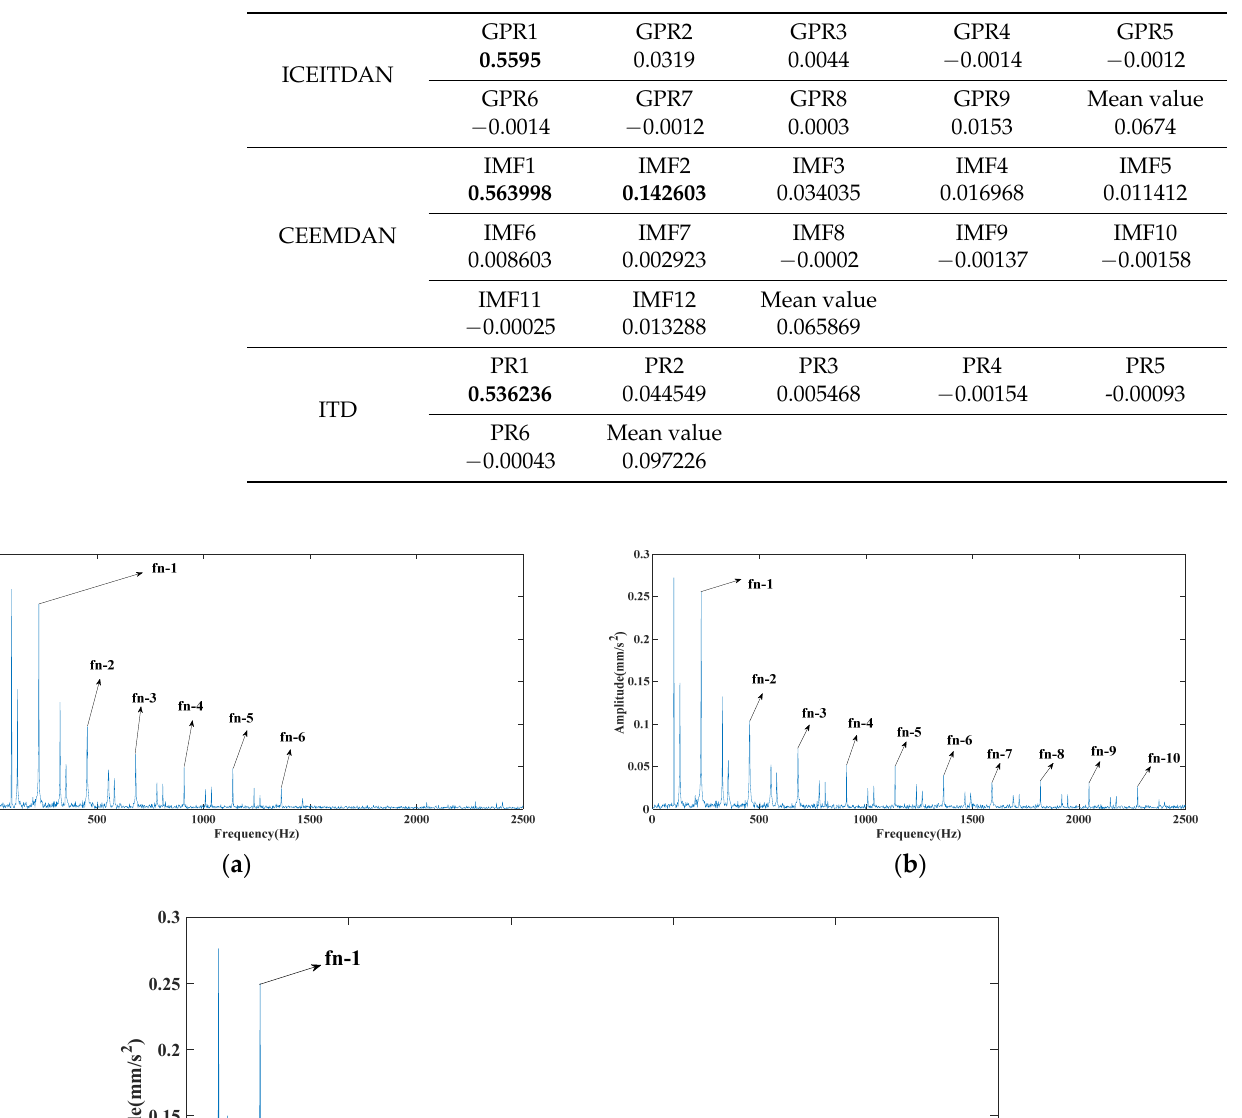
Table 2. PMGI values of different methods.